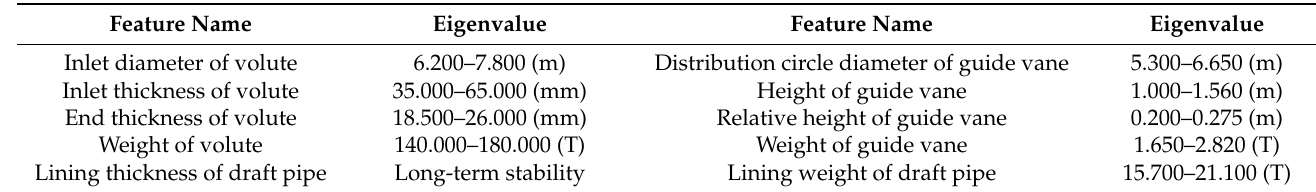
Table 1. Design requirement parameters of some runner